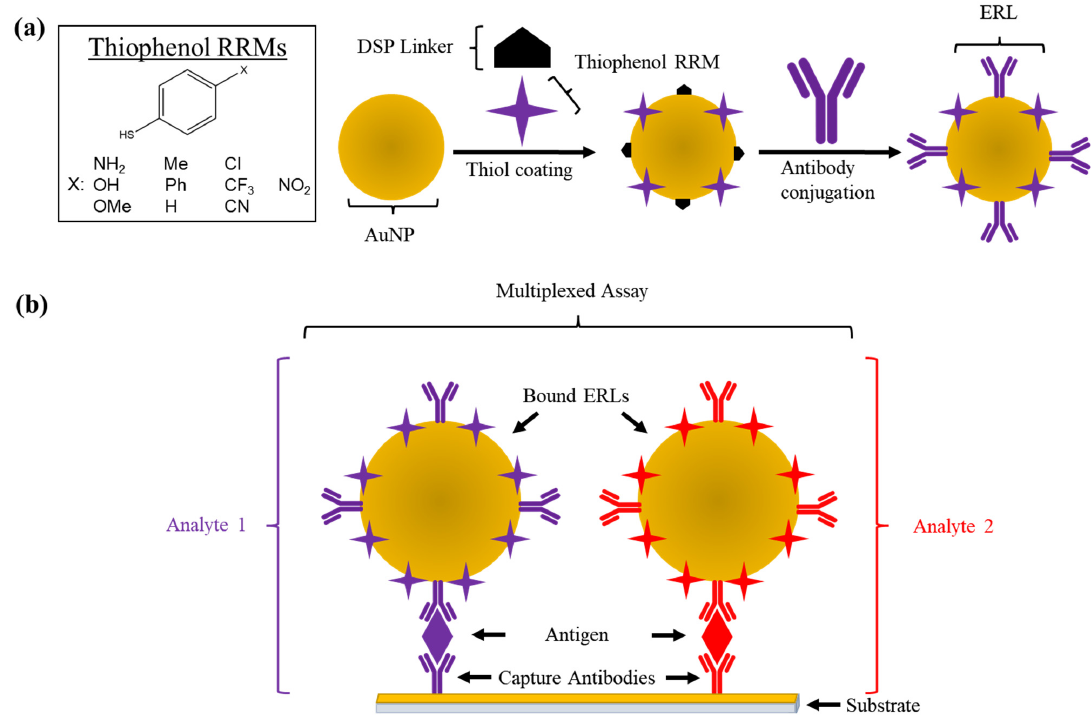
Figure 1. Preparation of ERLs and schematic of a multiplex SERS immunoassay biosensor. ( a ) The surface of an AuNP is decorated with a mixture of thiophenol RRM and detection antibodies. ( b ) Different ERL configurations in a multiplexed sensor allow quantification of additional markers using unique antibody/RRM pairs.